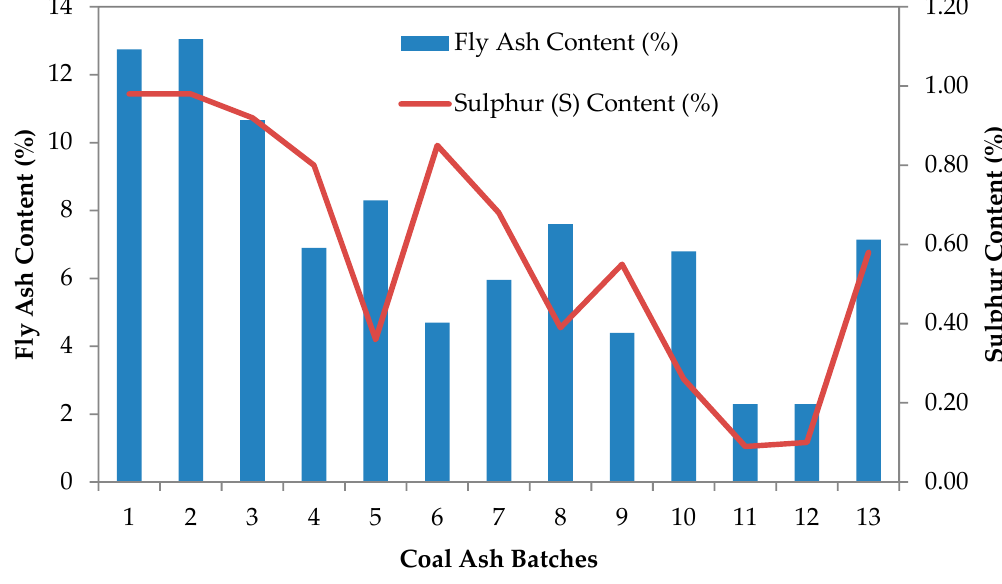
Figure 22. Fly ash–sulfur content of of a power plant from northern peninsular Malaysia.